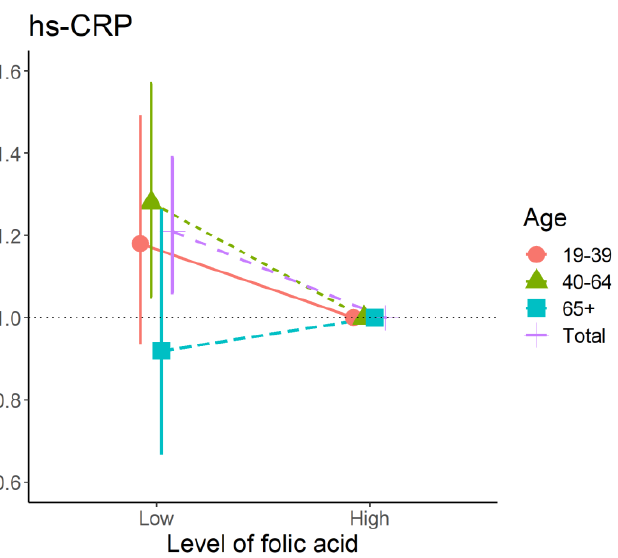
Figure 4. The association between the binary of folic acid and high–sensitivity C-reactive protein in each age group using multivariate logistic regression. Abbreviations: hs-CRP, high-sensitivity C-reactive protein.